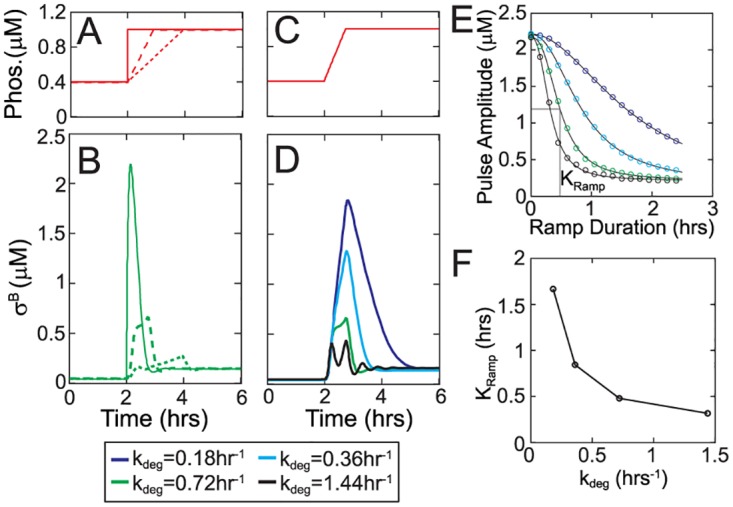
Rate sensitivity of the σB pulsatile response to environmental stress.A. Ramped increases in RsbTU complex concentration were used as model inputs to simulate different rates of stress increase in σB network. B. σB pulse amplitudes in the wildtype model (kdeg = 0.72 hr-1 is the degradation rate of σB operon proteins) resulting from the ramped increases in phosphatase concentration shown in (A). C,D. σB pulse amplitudes resulting from the ramped increase in phosphatase concentration shown in (C) for various degradation/dilution rates (D). E. Non-linear dependence σB pulse amplitude on phosphatase ramp duration for various degradation/dilution rates. Circles and solid curves represent simulation results and Hill-equation fits respectively. Colors represent different kdeg values as in (D). F. Kramp, the half-maximal constant of the non-linear dependence of amplitude on ramp duration, as a function of kdeg.